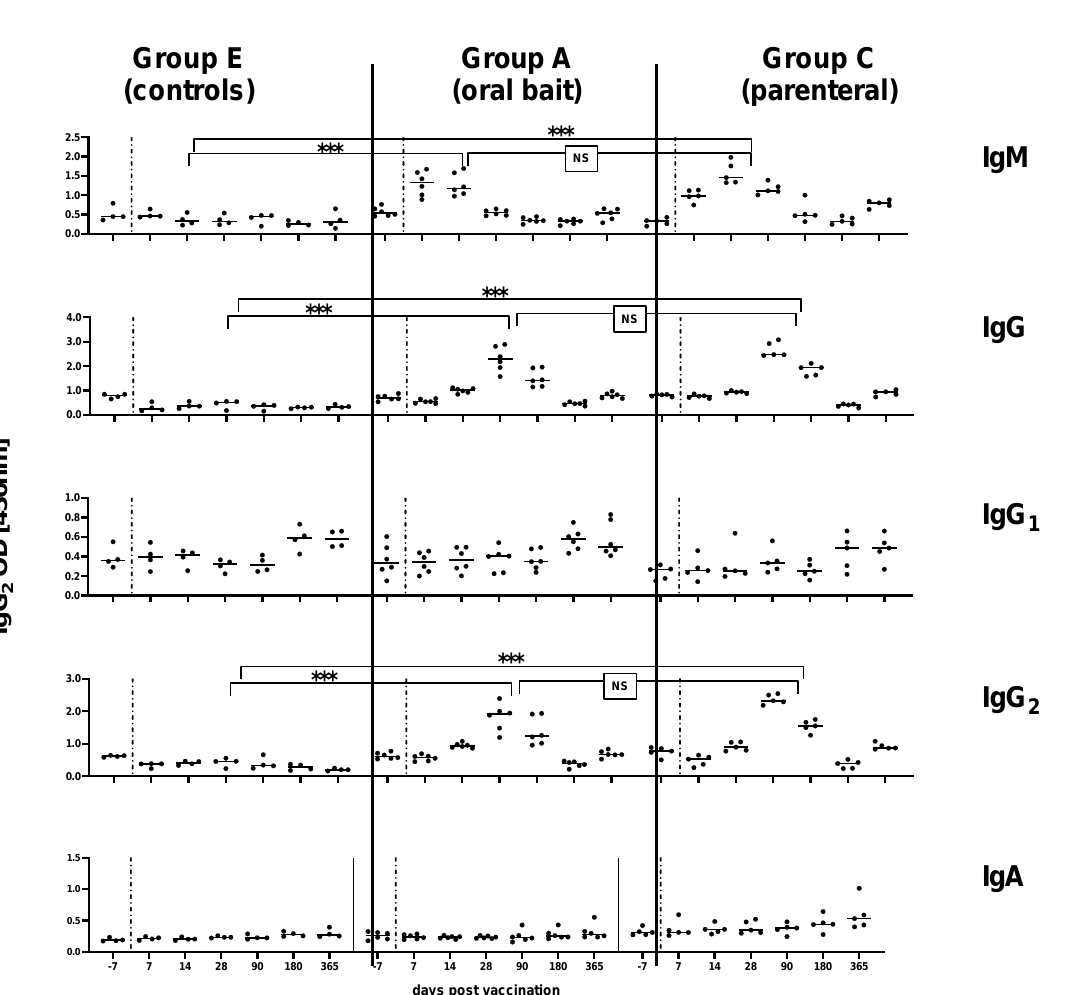
Figure 3. Kinetics of RABV specific immunoglobulin classes (IgM, IgG, IgA) and IgG isotypes (IgG1, IgG2) in the serum of naïve dogs (Group E) compared to orally (Group A) and parenterally vaccinated dogs (Group C) at di ff erent time points (days) pv. Each dot represents one individual animal with the median (solid line) depicted for each time point and each group. The vertical dashed lines represent the time point of vaccination. Statistical comparisons of the means for IgM (14 dpv), IgG (28 dpv), IgG 2 (28 dpv) between the di ff erent groups are indicated (Fisher’s t-test, p < 0.05, *** = extremely significant p: 0.0001 to 0.001; NS: not